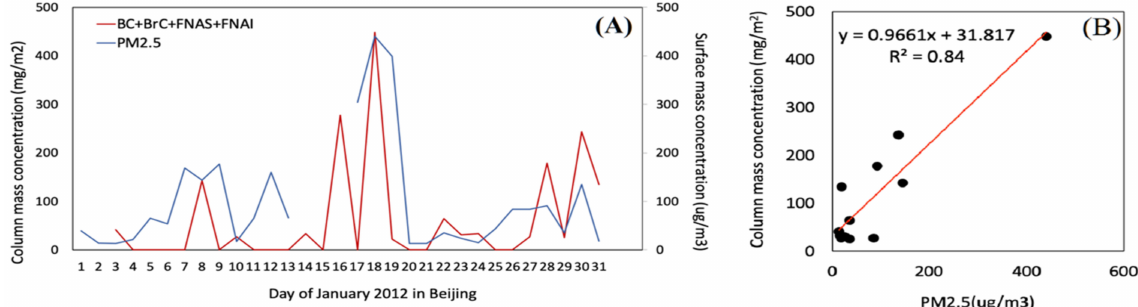
Figure 13. ( A ) Daily average of integral BC, BrC, FNAS, FNAI mass concentrations obtained from remote sensing retrieval compared with in situ PM 2.5 measurements during January 2012 in Beijing. ( B ) Correlation of PM 2.5 value with integral BC, BrC, FNAS, FNAI mass concentration during January 2012 in